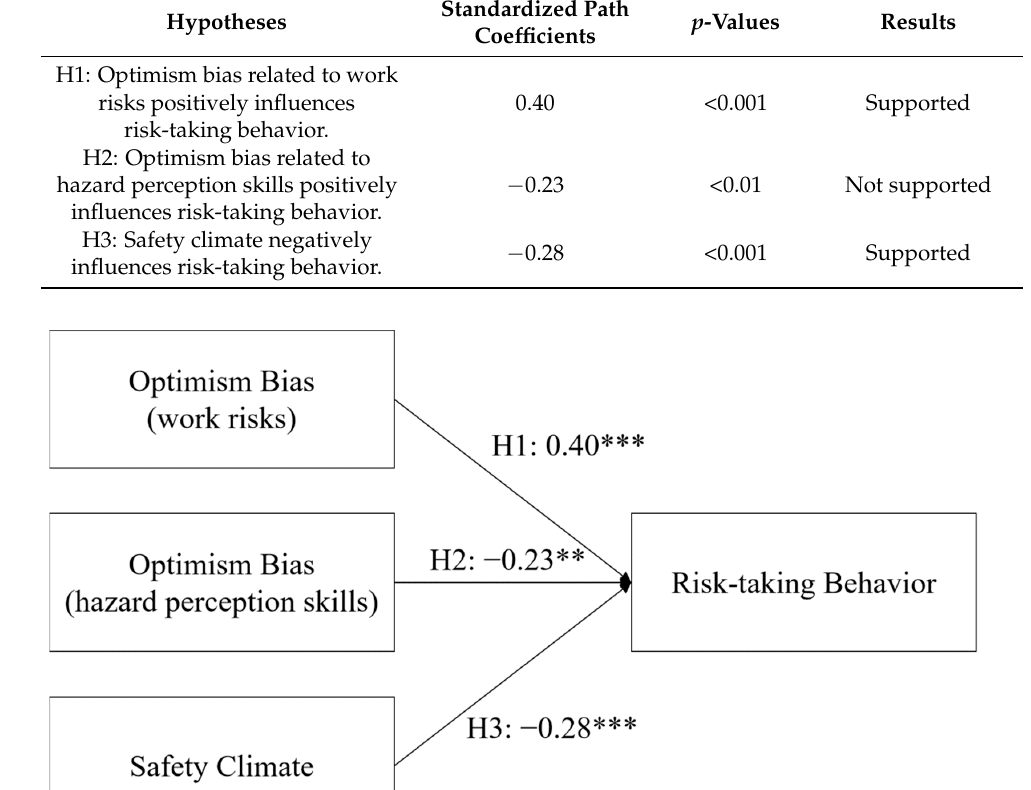
Table 6. Hypothesis testing results.